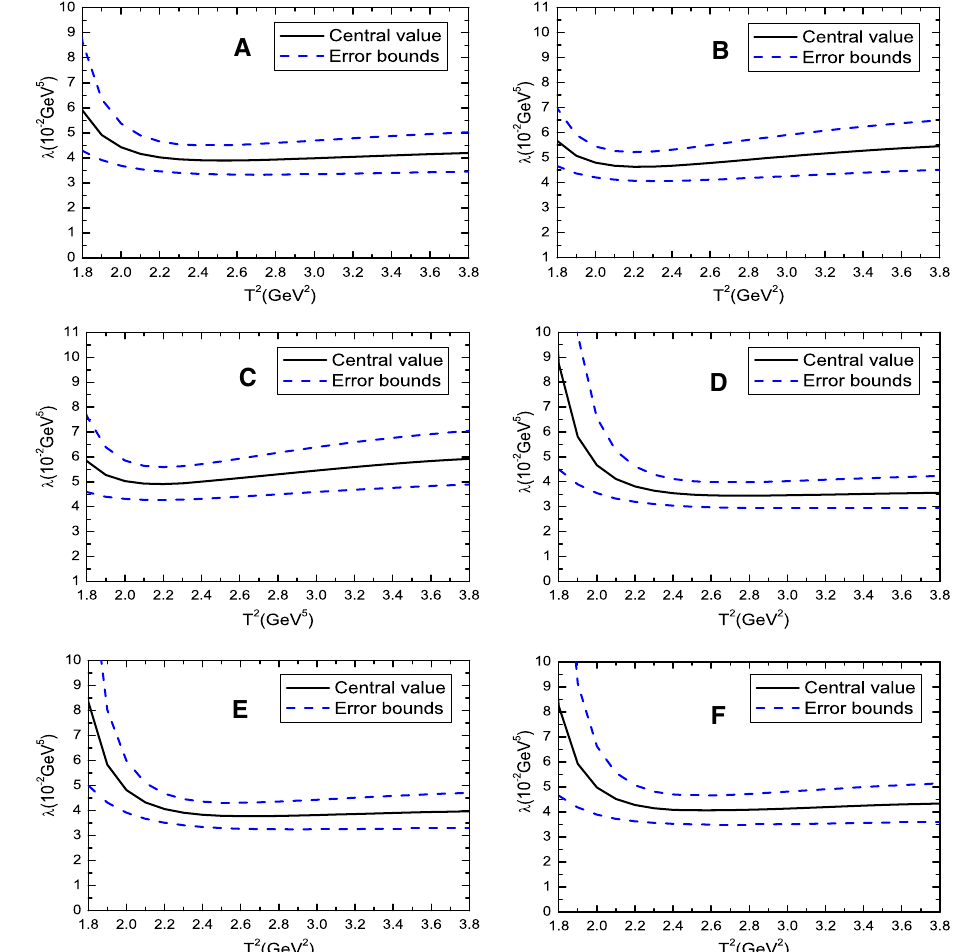
Fig. 4 ThepoleresidueswithvariationsoftheBorelparameters,where a – f denotethetetraquarkstates cc ¯ u ¯ d ( 0 + ) , cc ¯ u ¯ s ( 0 + ) , cc ¯ s ¯ s ( 0 + ) , cc ¯ u ¯ d ( 1 + ) , cc ¯ u ¯ s ( 1 + ) and cc ¯ s ¯ s ( 1 + ) , respectively